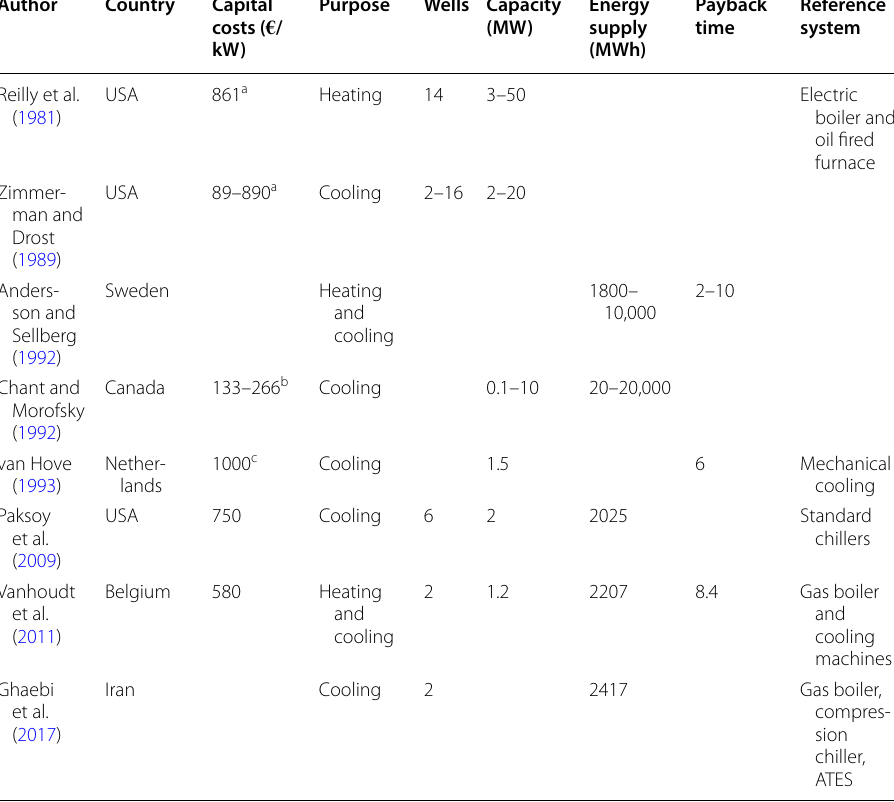
Exchange rates: a EUR/USD: 1.12, b EUR/CAD: 1.50, c EUR/NLG: 2.20